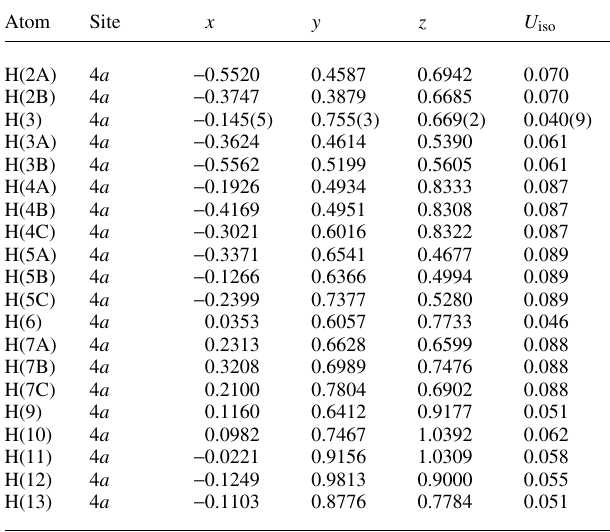
Table 2. Atomic coordinates and displacement parameters (in Å 2 )